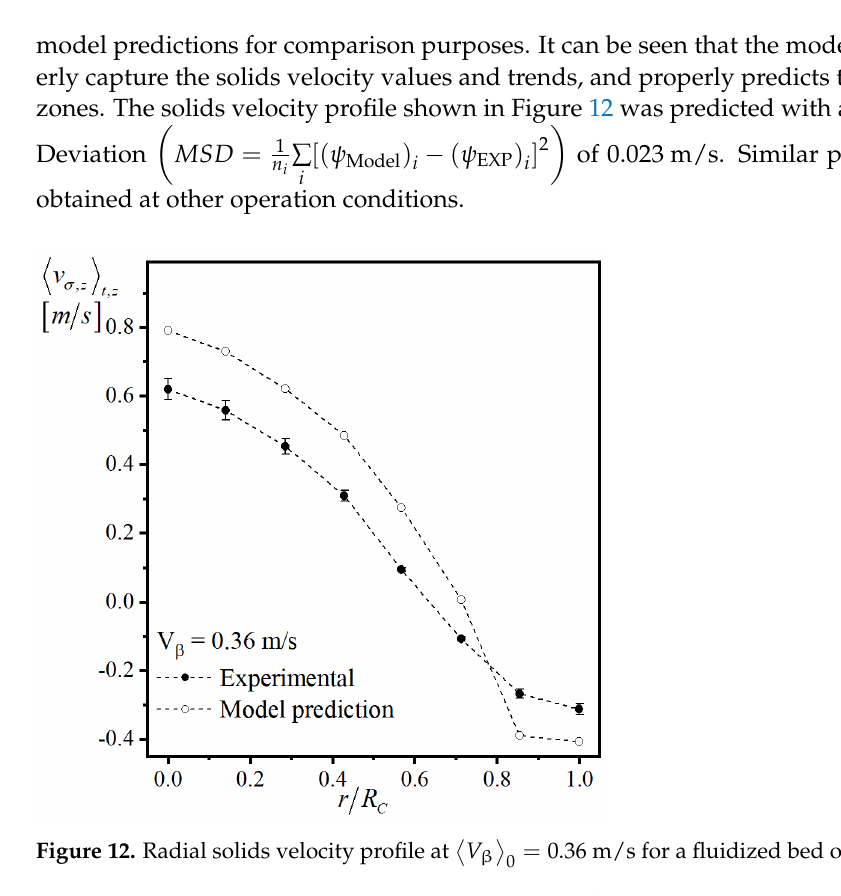
Figure 12. Radial solids velocity profile at